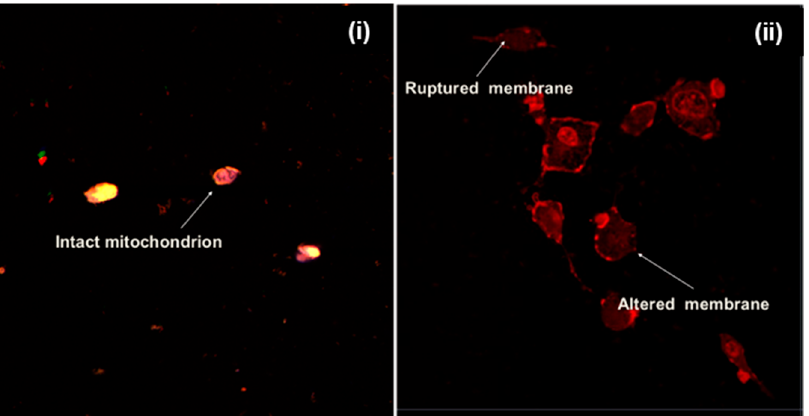
Figure 7. CLSM images of mitochondria stained with rhodamine 123 in live KYSE-30 cells. ( i ) Untreated KYSE-30 cells; ( ii ) KYSE-30 cells pre-incubated with LyP-1-functionalized ENT-loaded nanosystem. Changes in the configuration of the mitochondrial morphology and disruption of mitochondrial membrane showed apoptosis. Images were captured at 50 kx.